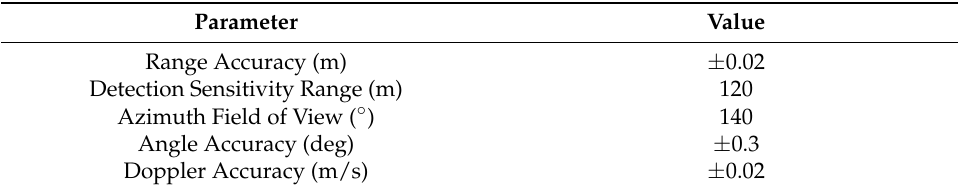
Table 2. Corner radar